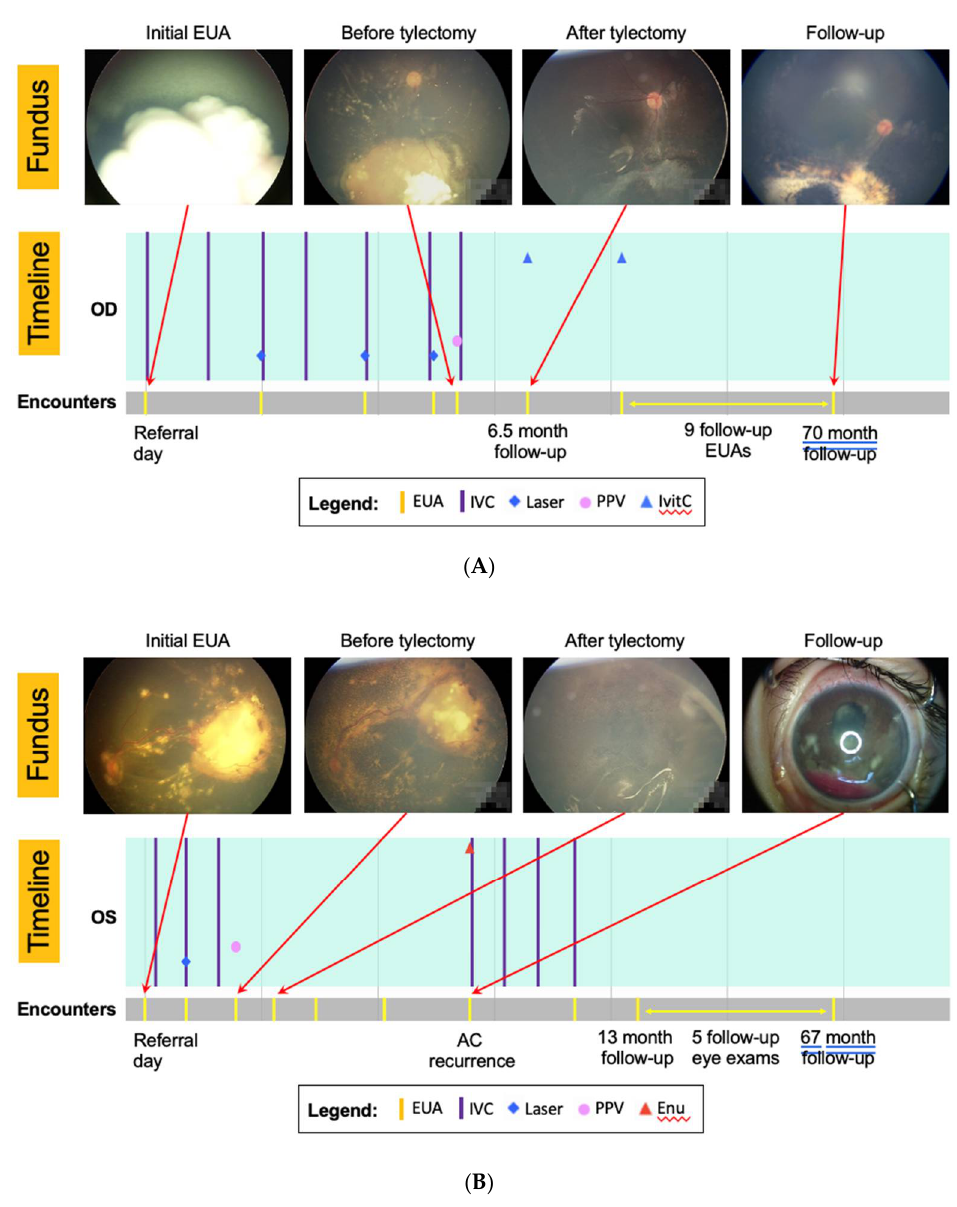
Figure 2. ( A ) Images and treatment timeline of patient #505 treated with tylectomy for refractory tumor who achieved good visual outcome. The patient was diagnosed with unilateral Group D retinoblastoma in the right eye at 2 years of age. Following 6 cycles of systemic chemotherapy, there was still a significant active tumor inferior to the optic disc and vitreous seedings. A tylectomy was performed to remove all active tumors inside the eye. One cycle of adjuvant systemic chemotherapy was given 2 days following tylectomy. There was no tumor recurrence at 70-month follow-up with visual acuity tested 20/100. IVC, intravenous chemotherapy; Ivitc, intravitreal chemotherapy. ( B ) Images and treatment